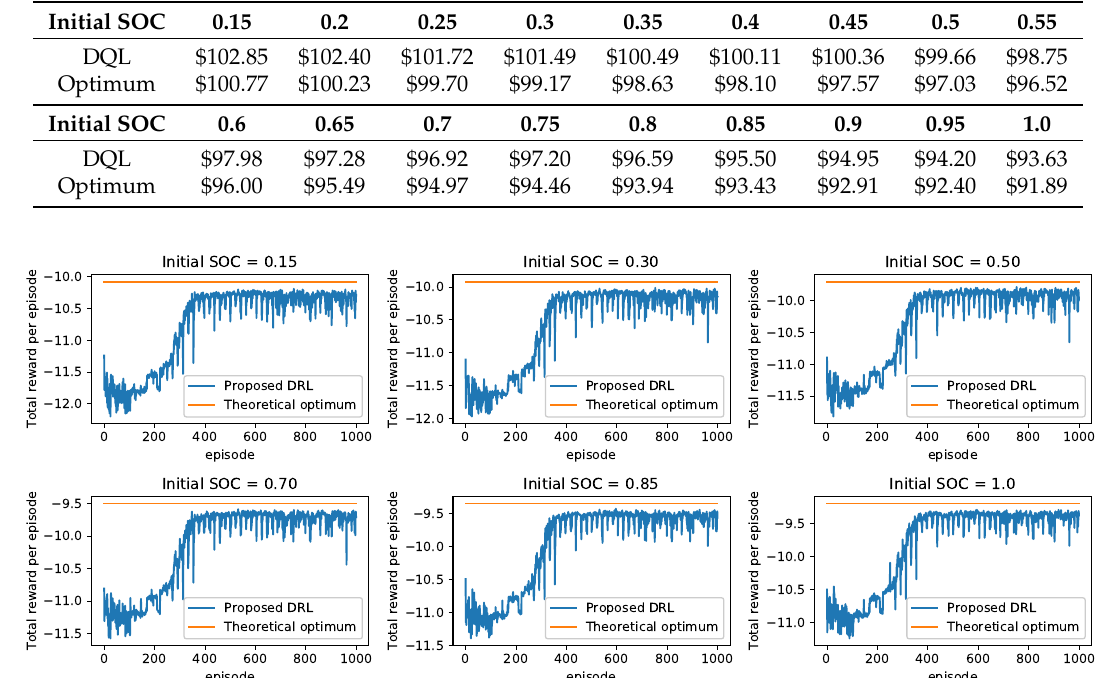
Table 2. Comparison of the operating costs obtained by the proposed DRL and the theoretical optimum.